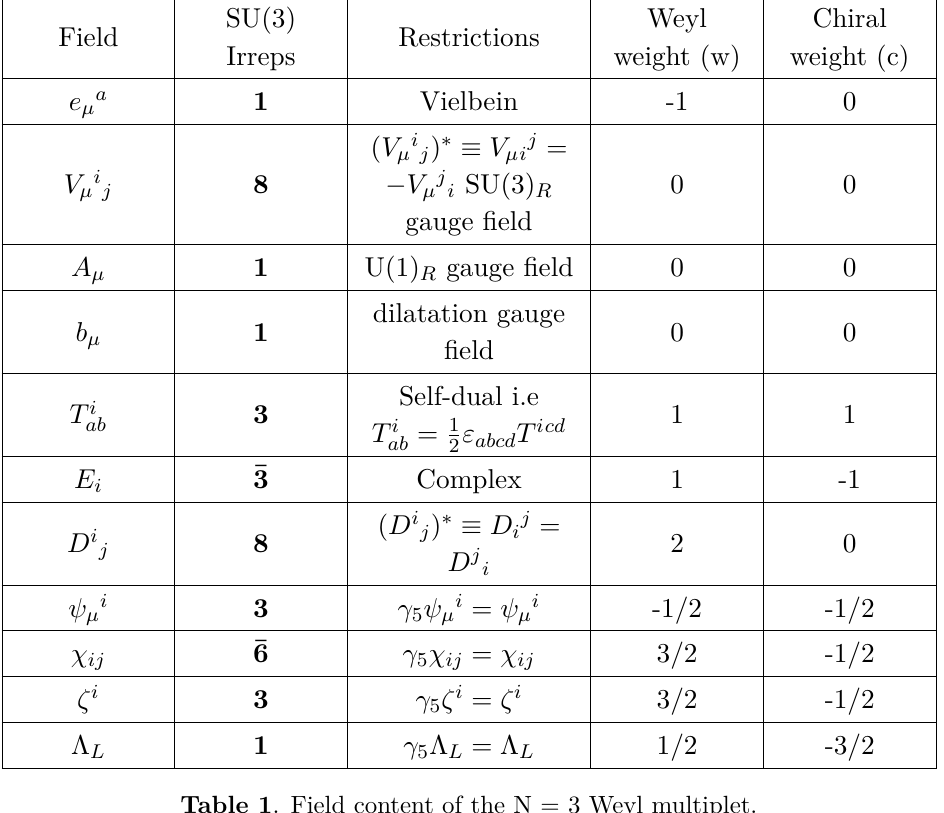
Table 1 . Field content of the N = 3 Weyl